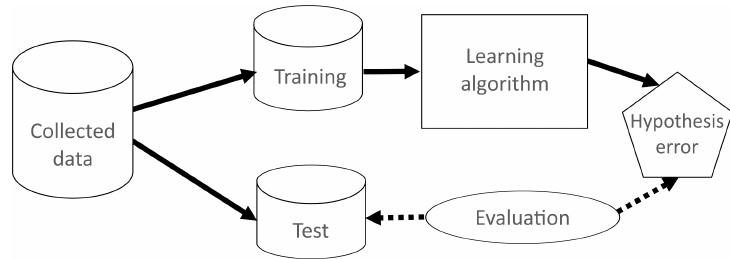
Figure 13. Evaluation of the data mining methods’ process.